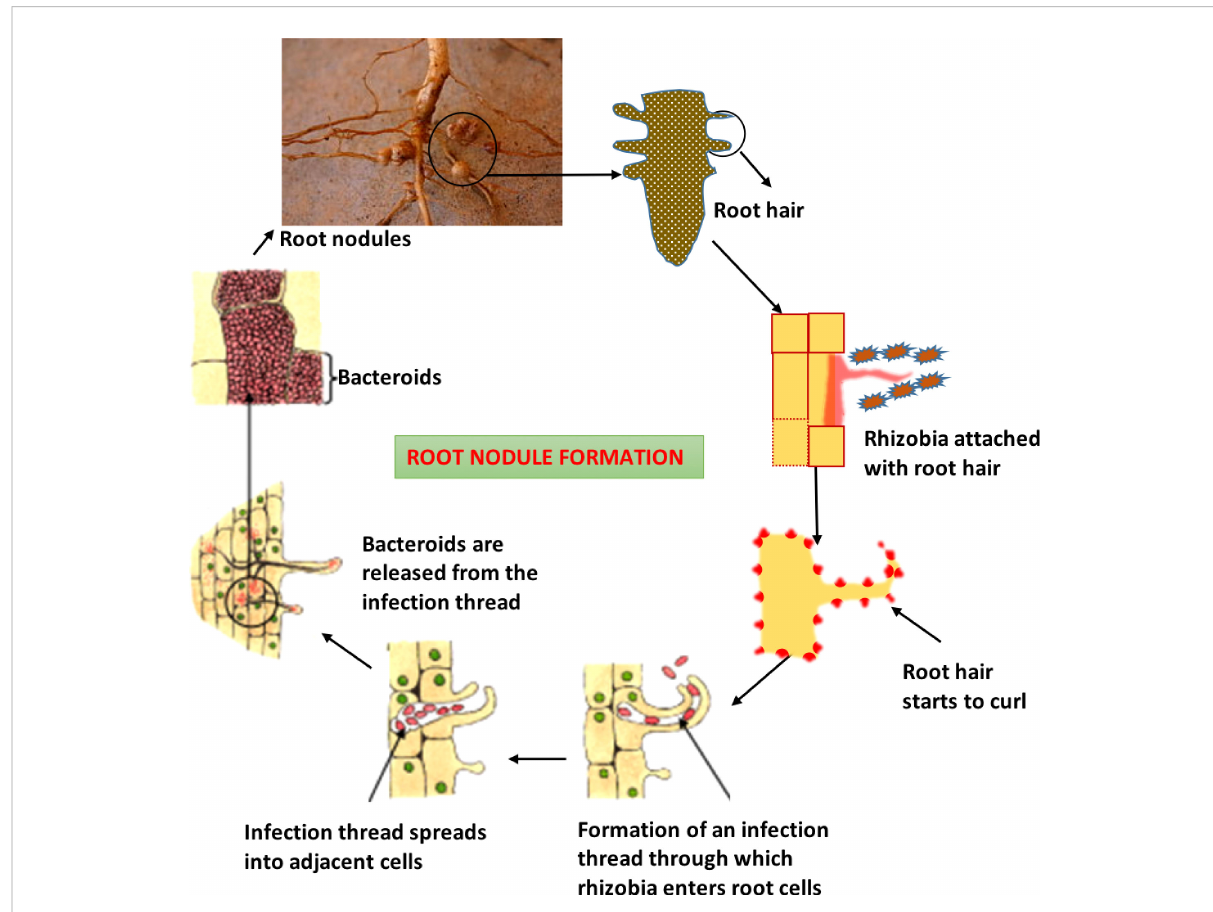
FIGURE 1 Diagrammatic representation of the whole process of nodule formation through